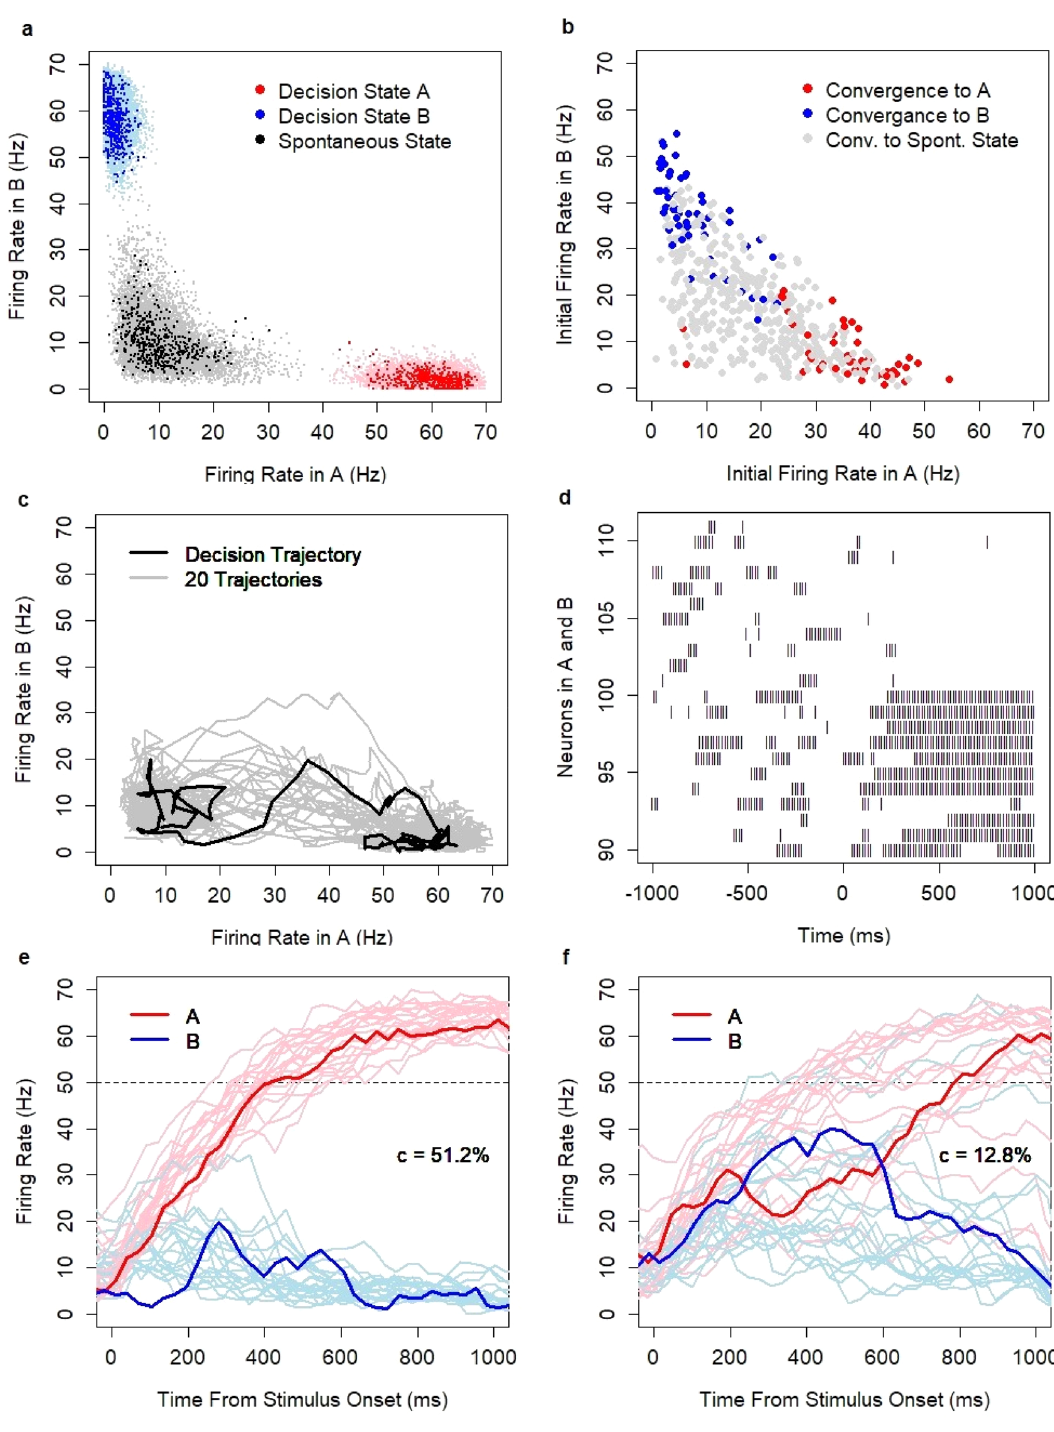
Figure 9. ( a ) The attractor states are the spontaneous state (black) and decision states A (red) and B (blue); N = 1500 data points (bold color), N = 30,000 data points (light hue). ( b ) Basins of attraction: convergence to a steady state within 1000 s from a randomly defined initial state measured within 50 ms after network initialization. ( c ) Decision trajectories for model runs with coherence level c = 51.2%. ( d ) Spiking activity of neurons in pools A (#90–100) and B (#101–111) before stimulus onset (− 1000–0 ms) and after providing input to pool A only (0–1000 ms). ( e ) Firing rate in pools A and B for model runs with coherence level c = 51.2% and threshold value indicated by the dotted line. ( f ) Firing rate in pools A and B for model runs with coherence level c = 12.8% and threshold value indicated by the dotted line. Thicker lines (in c , e , and f ) show a single model run selected from a wider range of model runs indicated by thinner